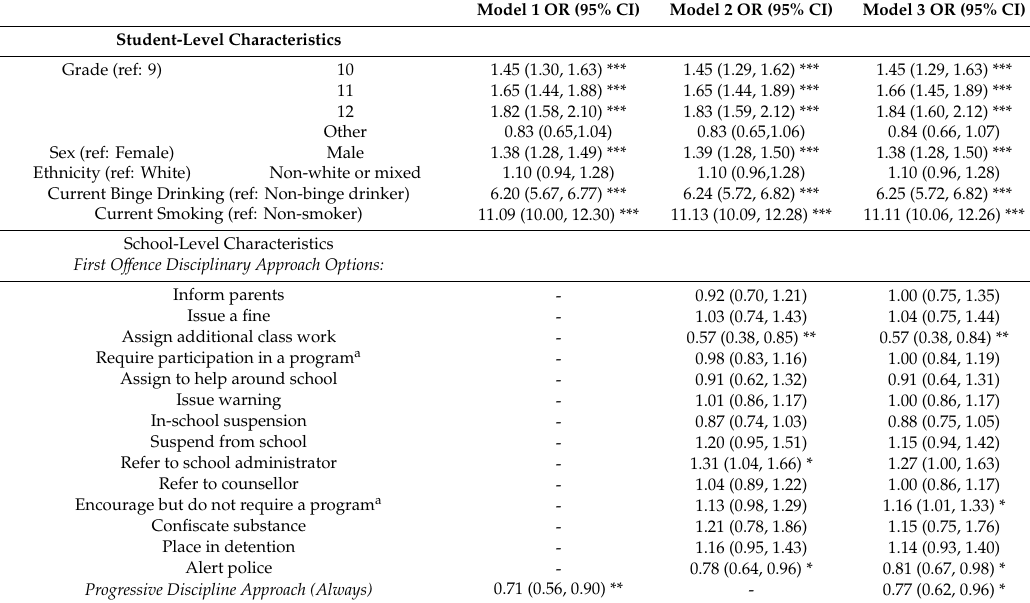
Table 6. Regression models for disciplinary approaches selected by schools as options used in response to school substance use policy violations and student cannabis use in Year 6 (2017 / 2018) of the COMPASS study ( n =